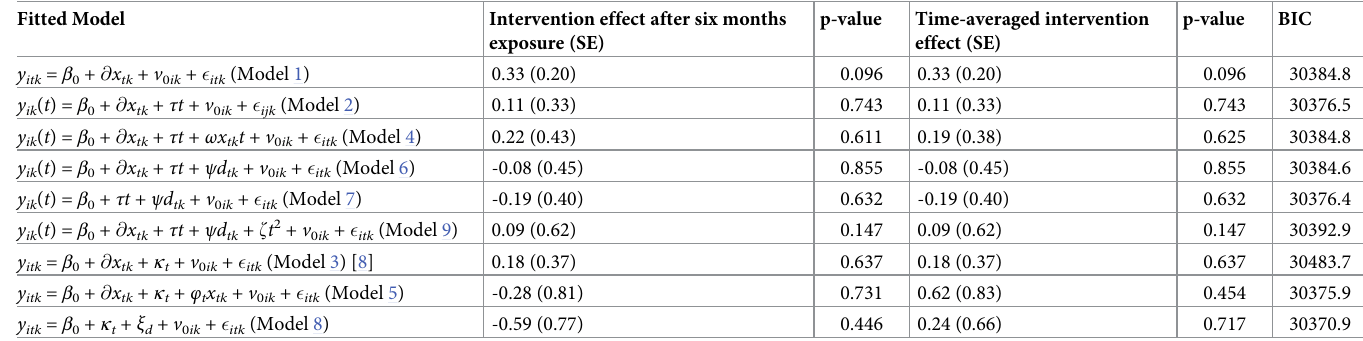
Table 4. Estimates of the treatment effect after six months exposure time to the intervention for the original OXTEXT-7 SWCRT data. Fitted